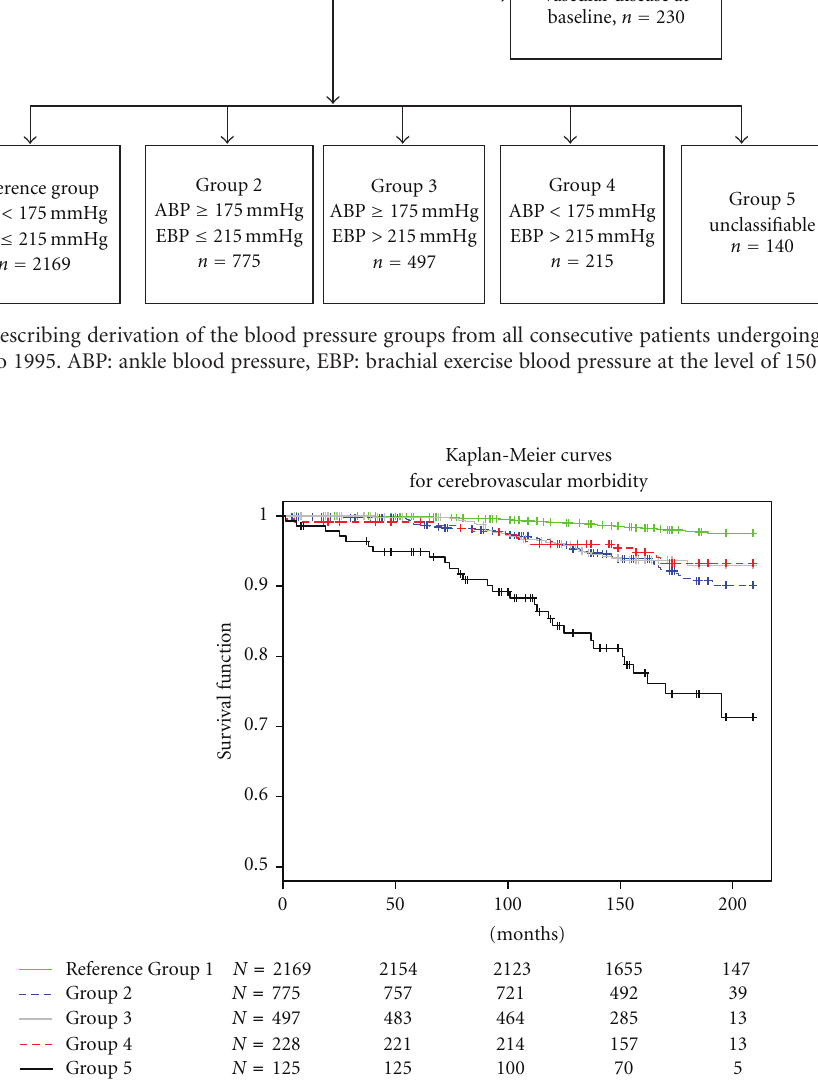
Figure 2: Kaplan-Meier curves for cerebrovascular (CV) events according to specified blood pressure group. Log-rank test for the di ff erence between the blood pressure groups: P < . 0001. The numbers indicate people remaining in the follow-up at di ff erent points in time. The reference group consists of patients with normal brachial pressure ( < 140mmHg), ankle blood pressure < 175mmHg and exercise blood pressure ≤ 215 mmHg at the moderate exercise level. Group 2 had elevated ankle blood pressure ( ≥ 175 mmHg), but normal exercise blood pressure. Group 3 had elevated ankle and exercise blood pressure. Group 4 had ankle blood pressure < 175mmHg but elevated exercise blood pressure (discrepancy), and group 5 could not be classified because of poor exercise